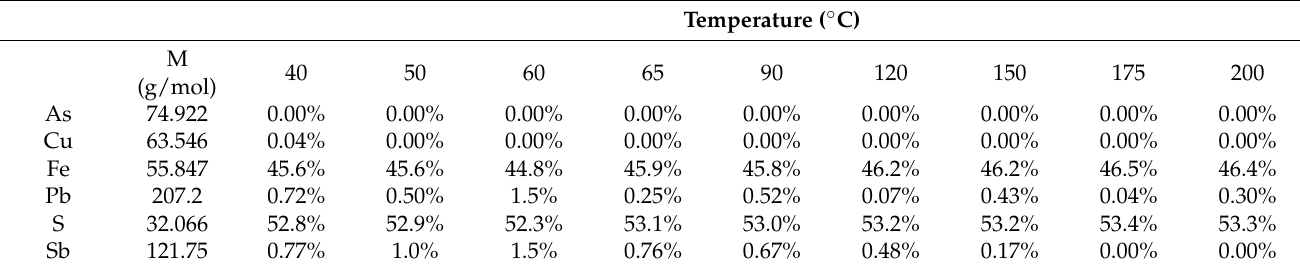
Table 12. Results of refined thermodynamic modelling in weight